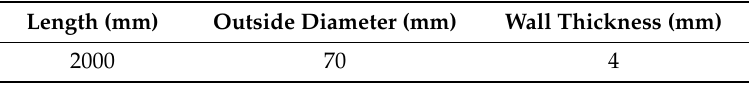
Table 4. The mechanical property parameters of steel material. Table 3. Dimensional parameters of the steel pipe model.